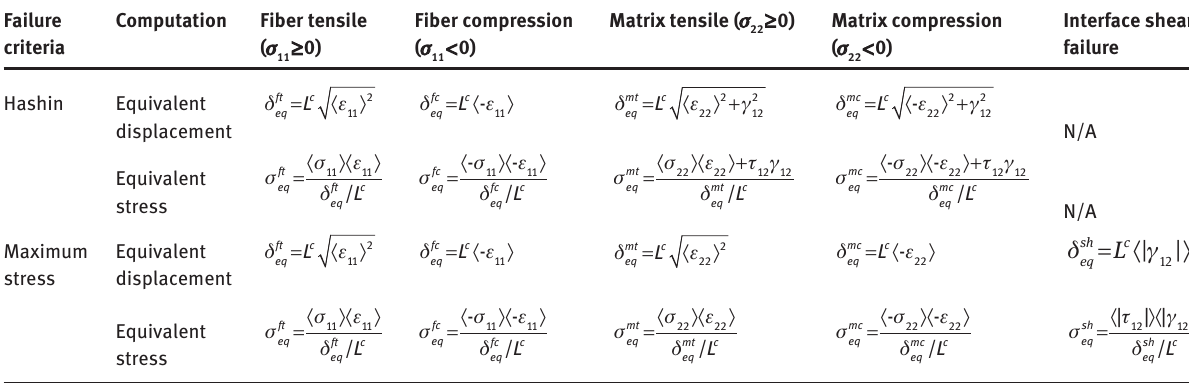
Table 5: Computing equivalent displacement and stress.